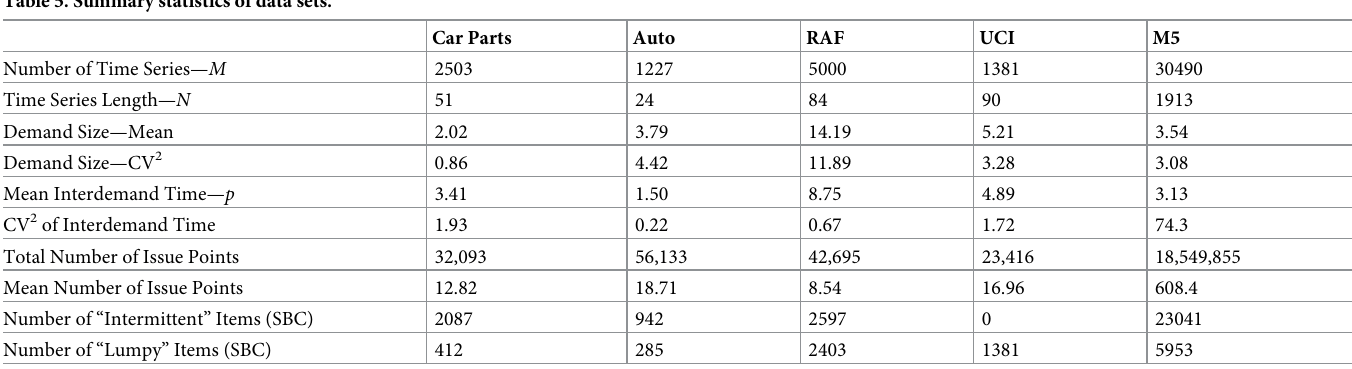
Table 5. Summary statistics of data